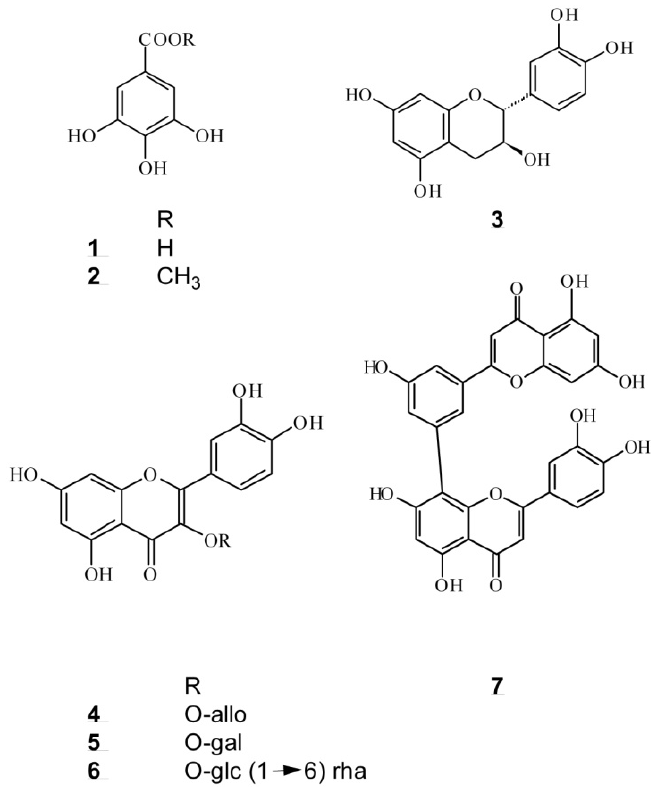
Figure 1. Compounds found in the leaves of Anacardium humile St.